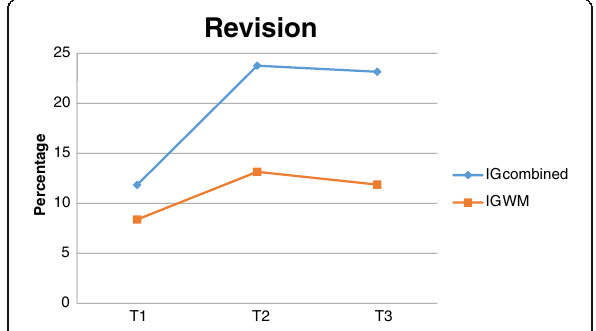
Fig. 3 Percentage of revision for IG-Combined and